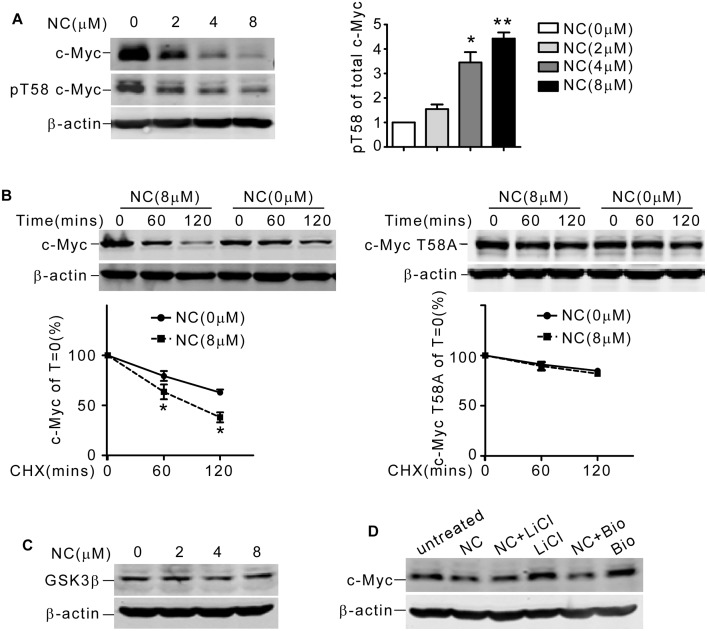
NC accelerated c-Myc degradation via enhanced Thr58 phosphorylation.(A) K562 cells were treated with 0, 2, 4 or 8μM NC for 2 days. c-Myc, phosphorylated c-Myc on Thr58 residue (pT58 c-Myc) and β-actin were detected by western blot. The values represent the means ± S.E. (n = 3). *, P< 0.05. **, P< 0.01. (B) After transfected with GFP-tagged wild-type (left panel) or c-Myc T58A mutant (right panel) plasmids, K562 cells were exposed to NC for 2hrs, then CHX chase assay was performed. c-Myc expression was detected by anti-GFP antibody. β-actin was used as loading control. The values represent the means ± S.E. (n = 3). *, P< 0.05. (C) K562 cells were treated with 0, 2, 4 or 8 μM NC for 2 days. GSK3β and β-actin levels were detected by western blot. (D) K562 cells were pretreated with GSK3β inhibitor LiCl (40 mM) or Bio (0.5 μM) for 2hrs, and then cells were exposed to 8 μM NC for 24 hrs. c-Myc and β-actin were detected by western blot.